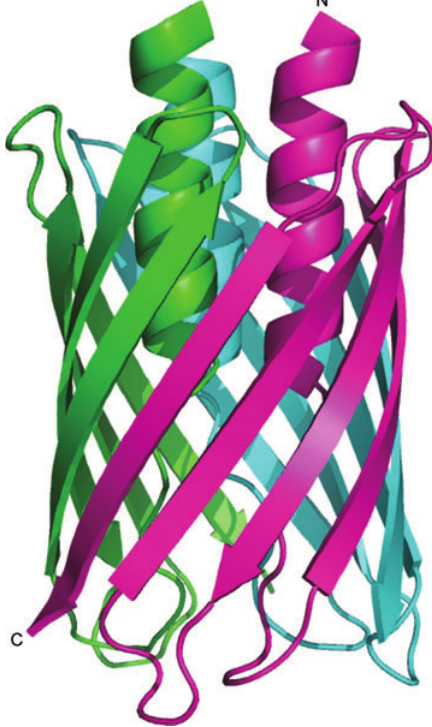
Figure 9 The structure of the translocator domain of H. infl uenzae Hia trimeric autotransporter. The N- and C- termini of the chain shown in pink are indicated. The model shown is PDB entry 2GR8 (68)